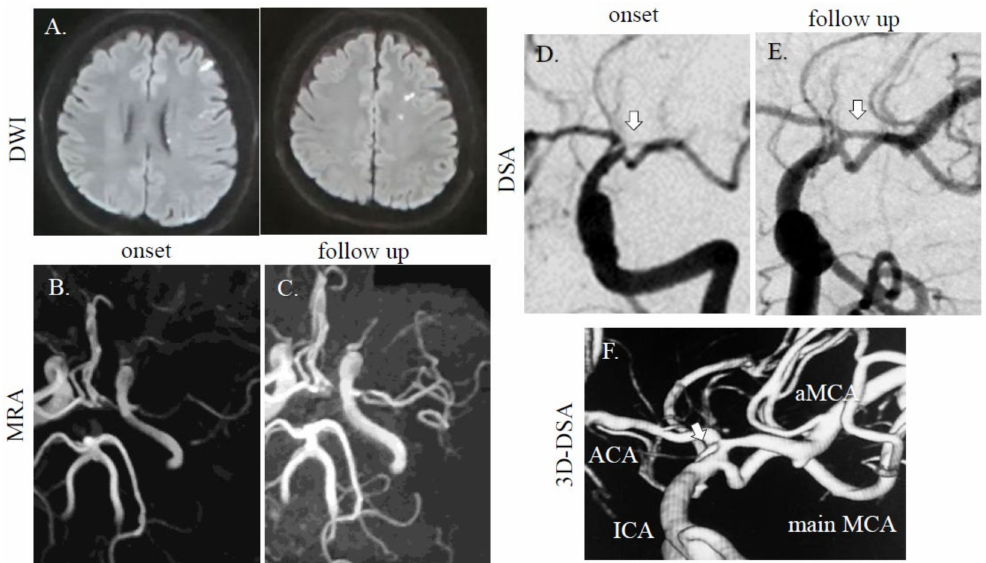
Figure 1. MRI/A and digital subtraction angiography (DSA) images of cases 1. ( A ) A dotted high-intensity area was observed in the left middle cerebral artery (MCA) distal area. In case 1, the left MCA was faint at onset ( B ), but accessory MCA was noted on follow-up ( C ) on MRA. On DSA, one intact MCA and one stenotic MCA (arrow) were found ( D ). In the follow-up study, stenotic MCAs were recovered ( E ). On 3D-DSA, dissection scar was still noted at origin of main/accessory MCA ( F ; arrow). Diffusion-weighted images (DWI); repetition time (TR), 7000 ms; echo time (TE), 120 ms. MRA (without using contrast agent); TR, 30 ms; TE, 6.8